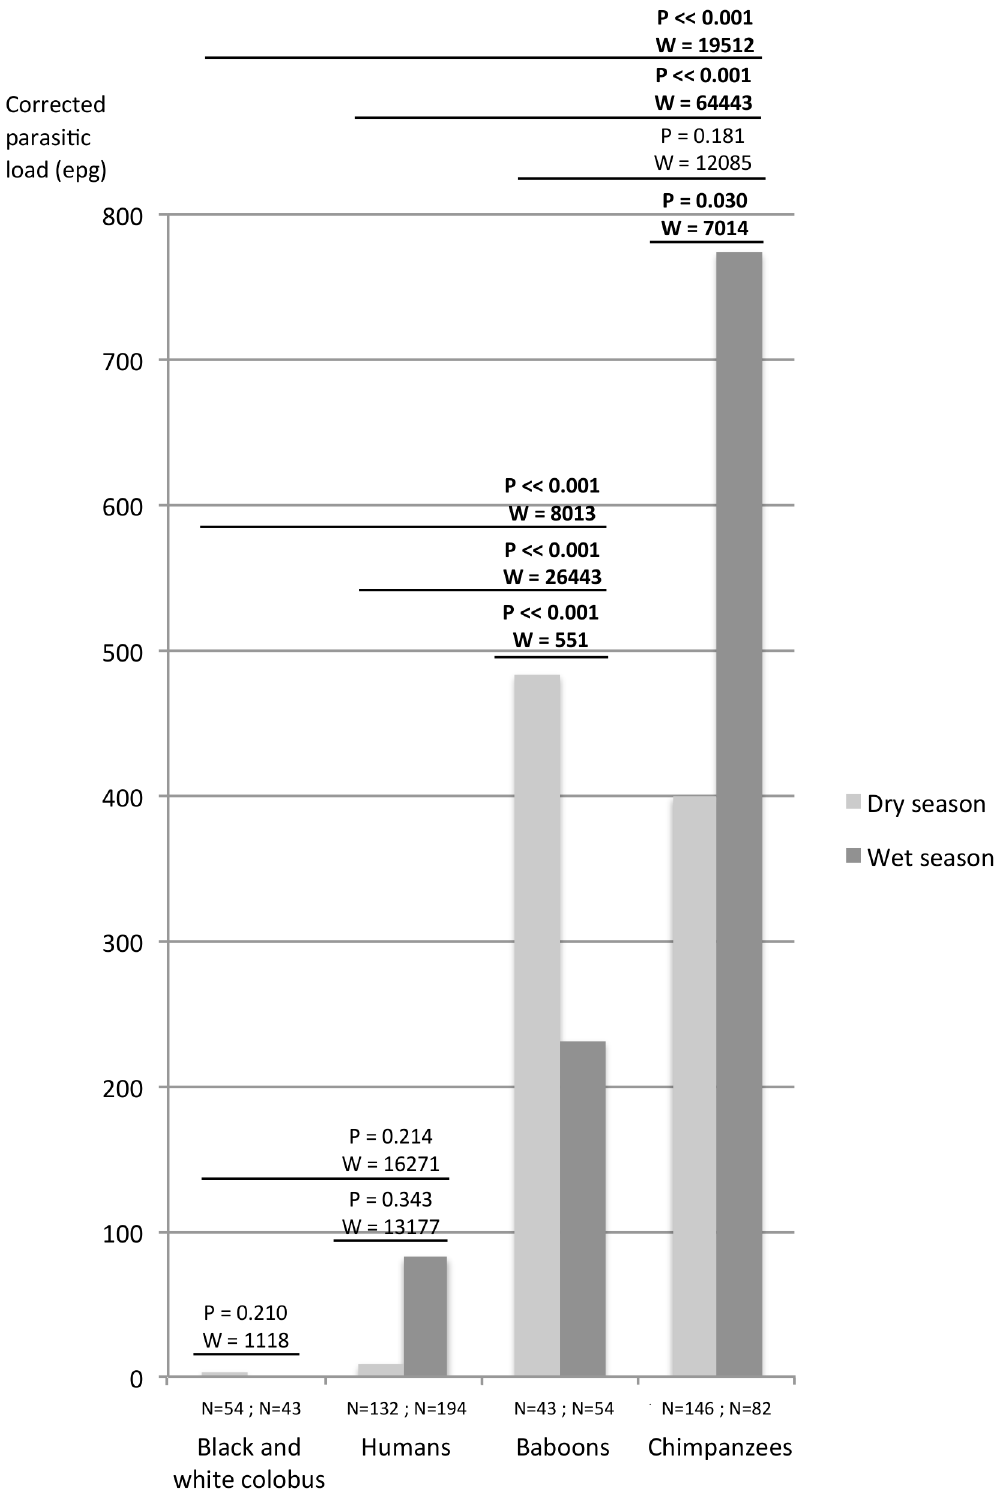
Fig 2. Mean corrected parasitic loads (eggs per gram) according to primate species and according to the season per species (Mann-Whitney tests; NS non significant; * p < 0.05; ** p < 0.01; *** p < 0.001).